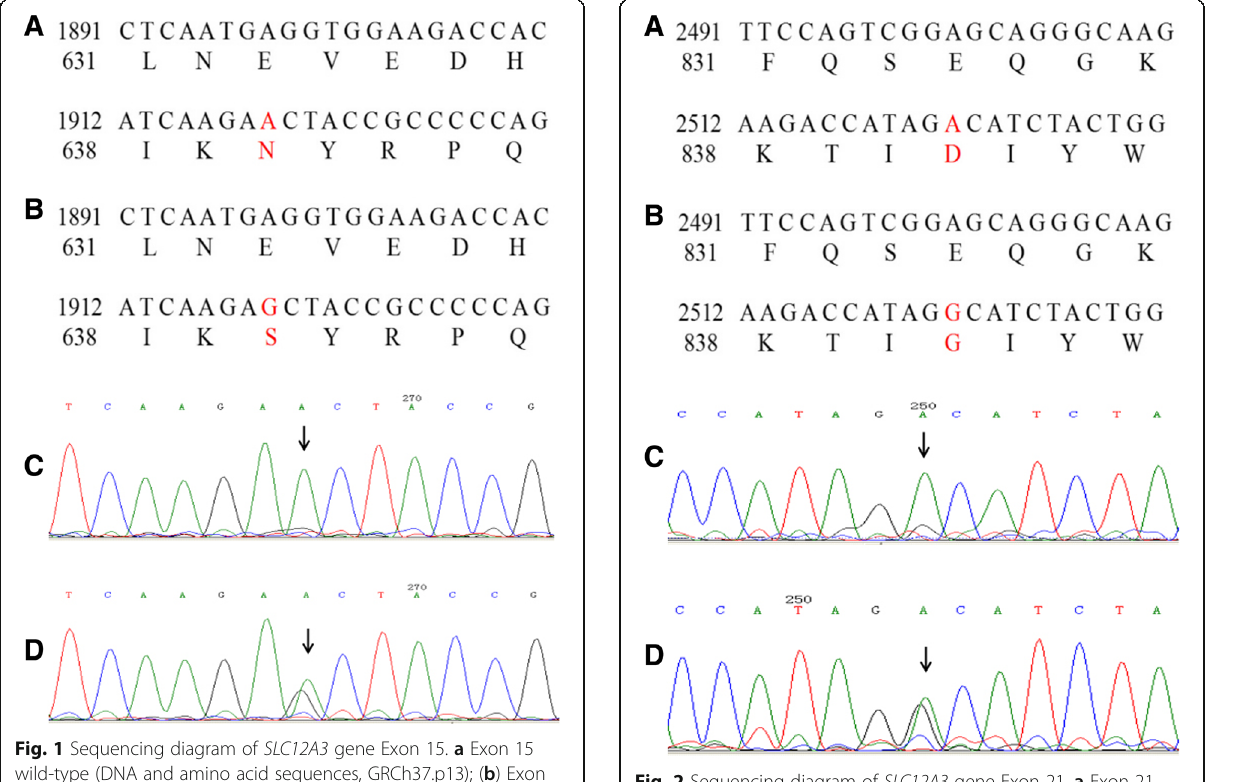
Fig. 2 Sequencing diagram of SLC12A3 gene Exon 21. a Exon 21 wild-type (DNA and amino acid sequences, GRCh37. p13); ( b ) Exon 21 heterozygous mutation, A2522G, GAC → GGC, Asp841Gly (D841G); ( c ) Exon 21 wild-type (Sanger sequencing); ( d ) Exon 21 het- erozygous mutation type (Sanger